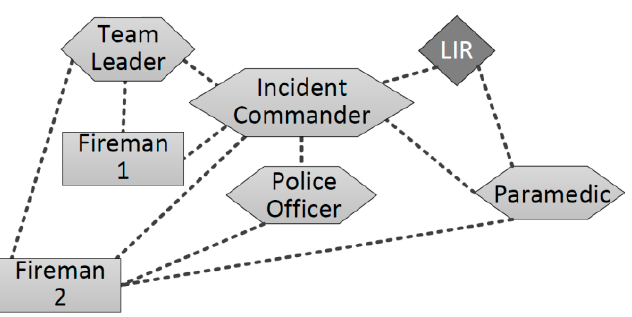
Figure 9. Interaction scenario